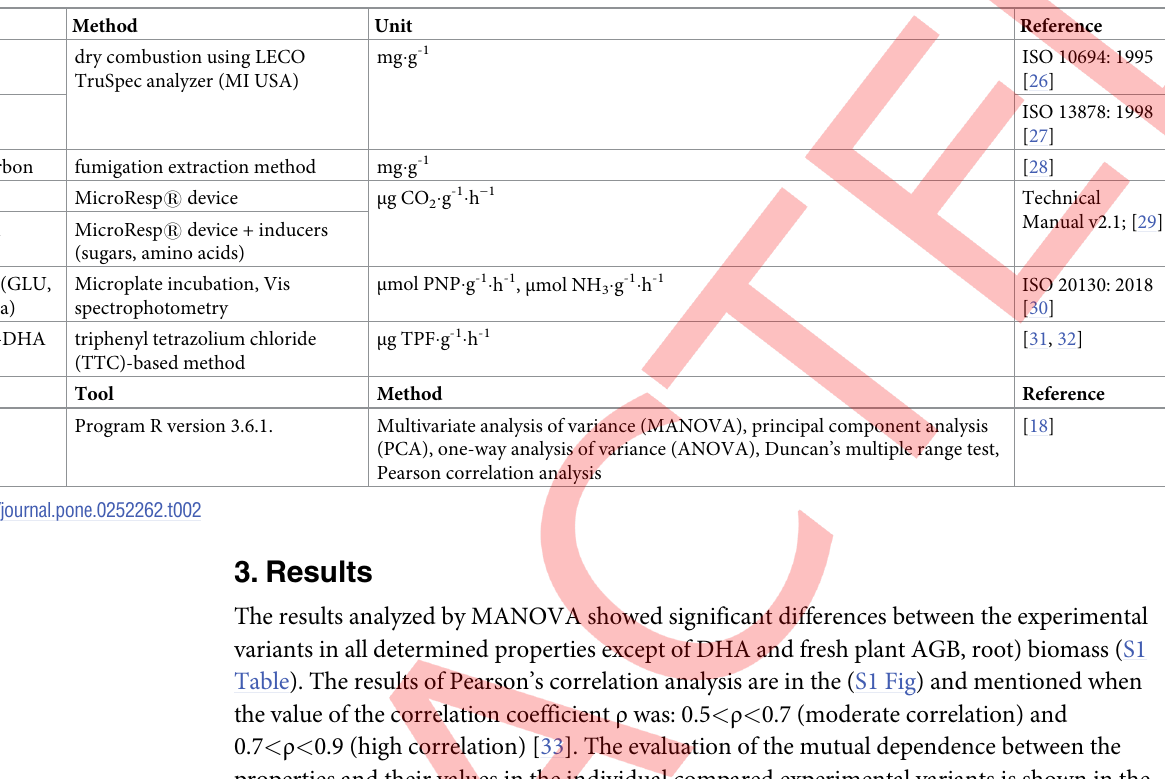
Table 2. Determined soil properties, methods used for measurement and statistics, relevant